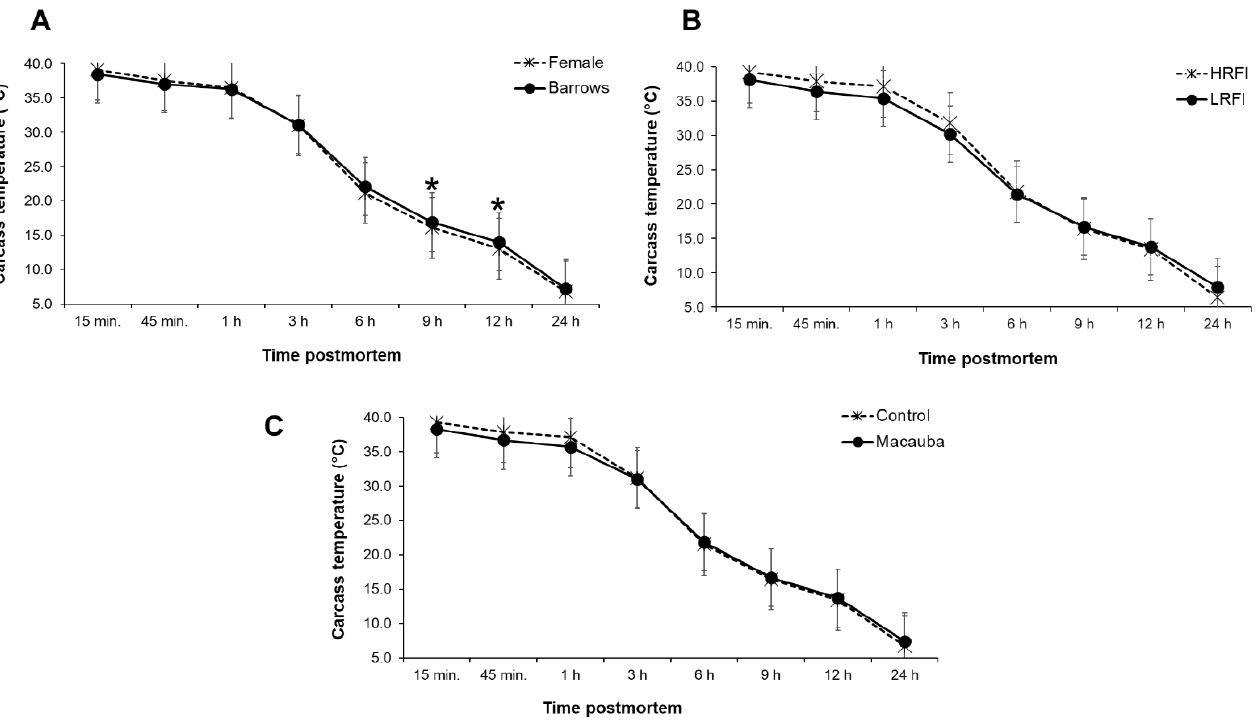
Figure 2. Effect of sex ( A ); sire breeding value ( B ); and diet ( C ) on carcass temperature decline during the first 24 h postmortem . Progeny of sires with high (HRFI) or low (LRFI) breeding value for residual feed intake. Each vertical bar is the standard error of the mean. * p <